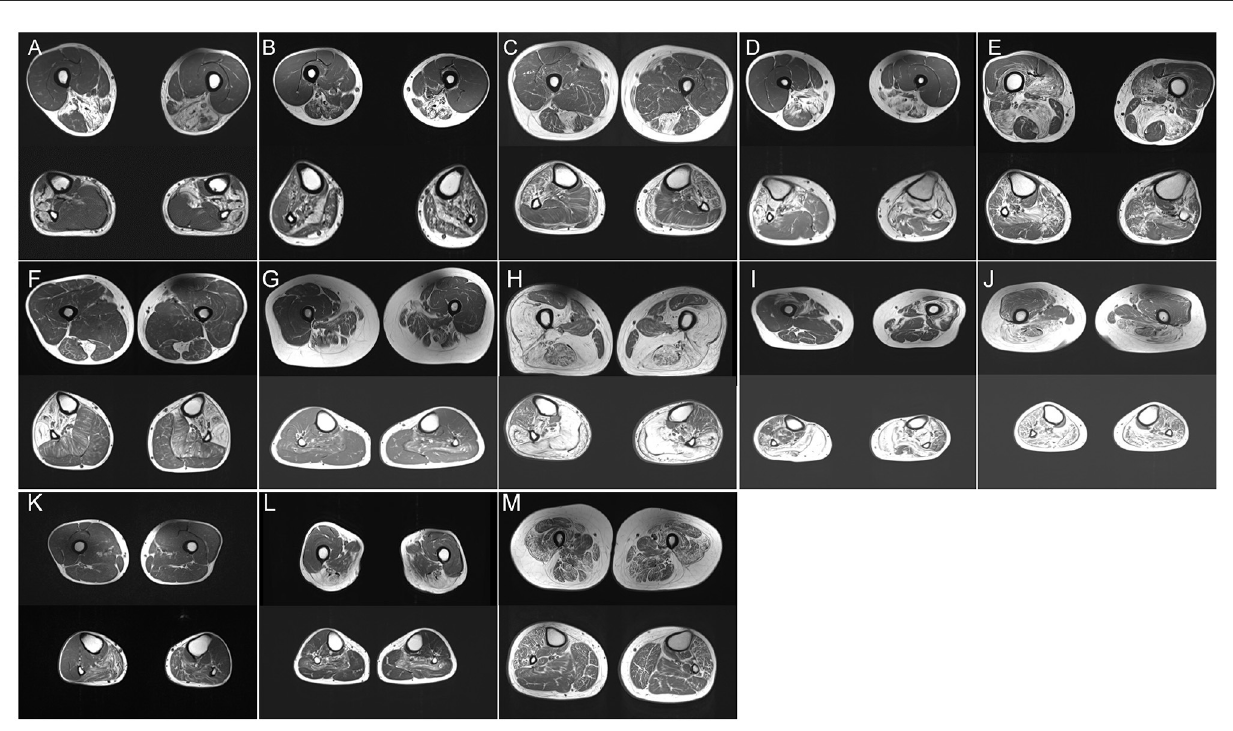
FIGURE1 (A–M) Thigh and calf muscle MRI (T1-weighted images) of P2 (A) , P12 (B) , P14 (C) , P15 (D) , P17 I, P18 (F) , P19 (G) , P20 (H) , P21 (I) , P22 (J) , P23 (K) , P24 (L) , and P27 (M)